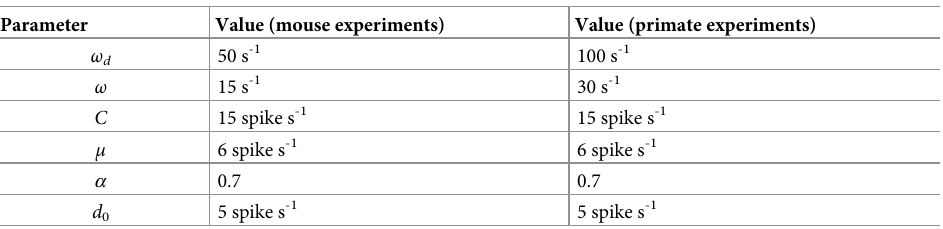
Table 1. Parameter values. Parameter Value (mouse